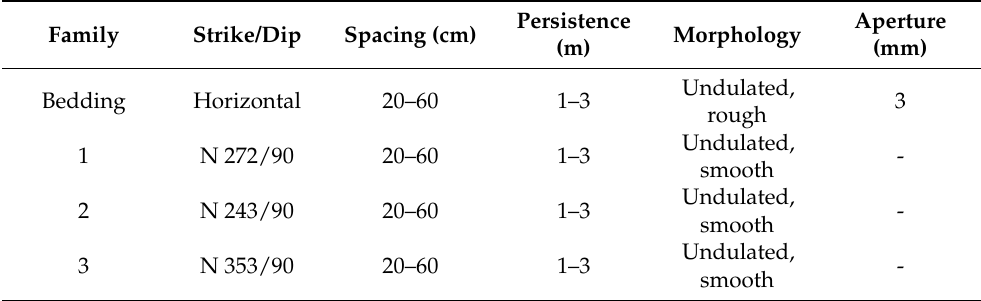
Table 2. Orientation and main features of the discontinuities in the DC